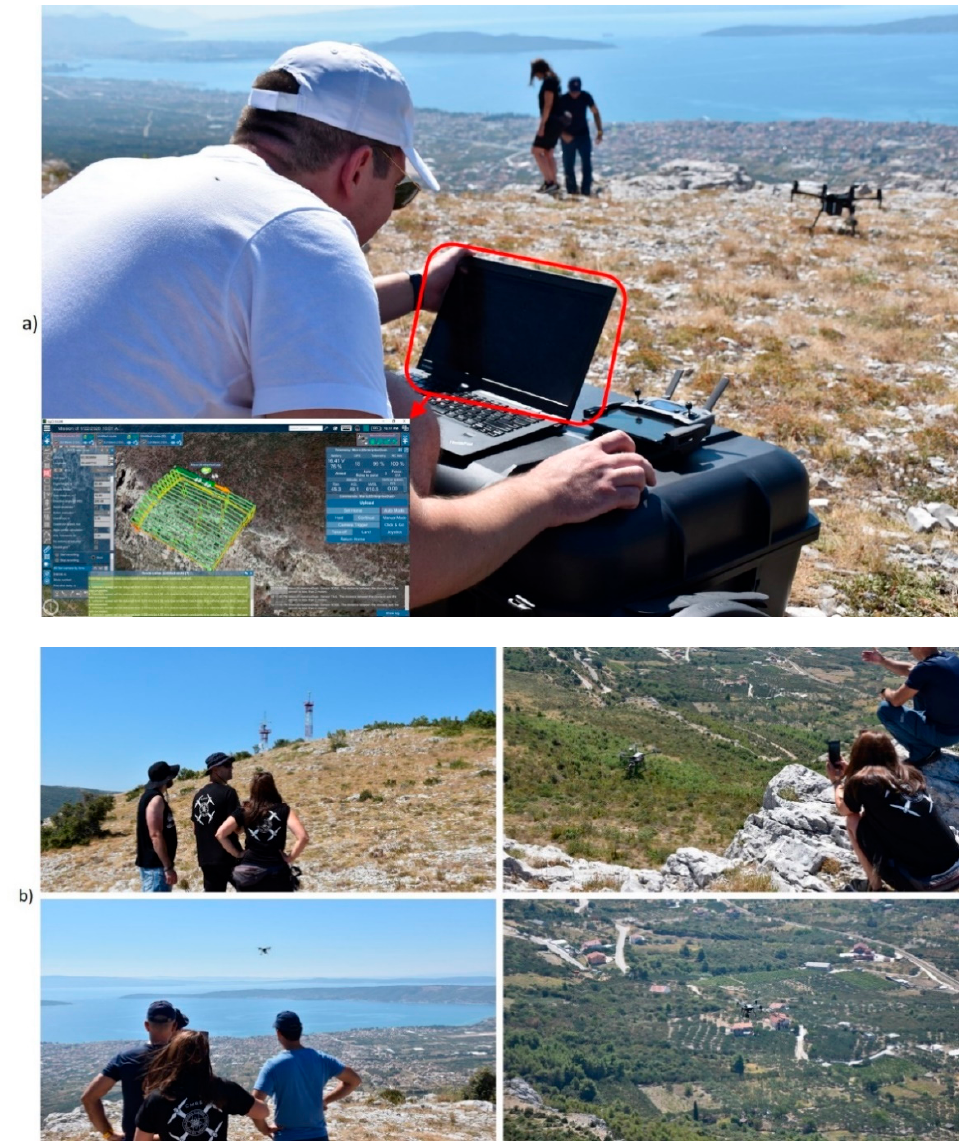
Figure 4. ( a ) Preparation of the drone flight for the search mission; ( b ) carrying out the search mission with Unmanned Aircraft Systems (UASs). Table 2. Information about SAR missions used within this experiment; NH—number of persons, IWH—number of images without persons, INotH—images without persons.